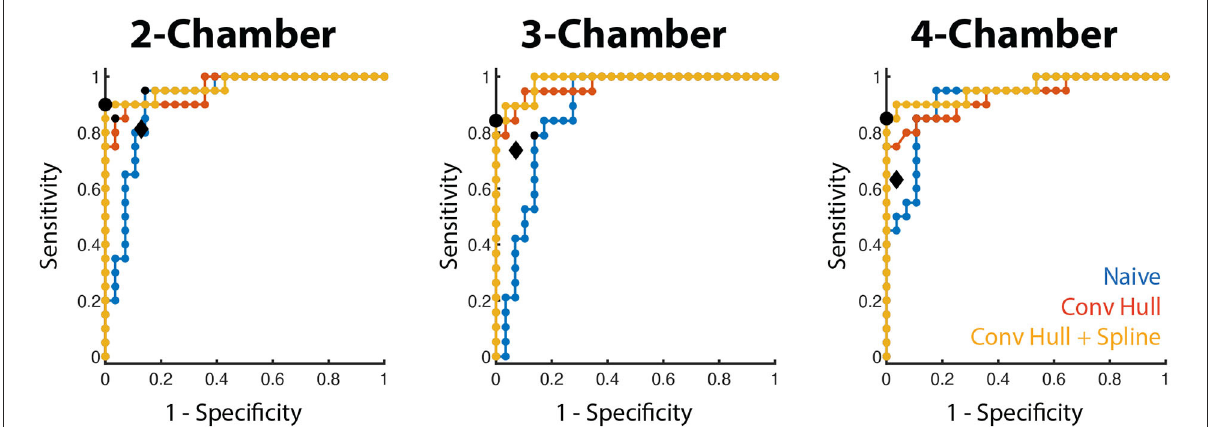
FIGURE5 WMA classification accuracy using LS in the training cohort. Receiver operating characteristic curves for the three long-axis views are shown for the three LS methods (blue: naive, red: convex hull, orange: convex hull + curve fitting). The optimal operating point for the convex hull with curve fitting is depicted by a black dot. The operating point of the convex hull with curve fitting in the testing cohort is shown by the black diamond.